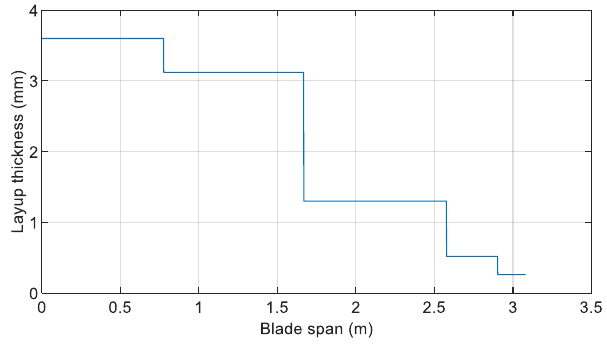
Figure 14. Blade shell layup